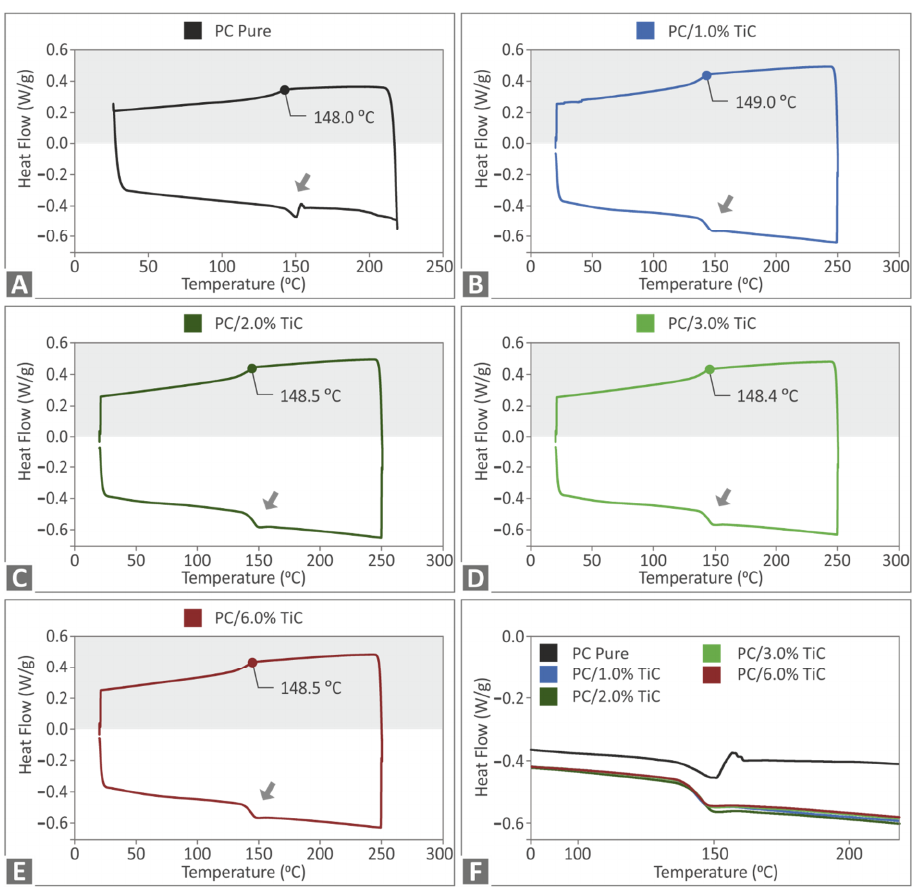
Figure 4. DSC exotherm and endotherm heat flow curve (W/g) to temperature ( ◦ C) for: ( A ) pure PC, ( B ) PC/TiC 1 wt.%, ( C ) PC/TiC 2 wt.%, ( D ) PC/TiC 3 wt.%, ( E ) PC/TiC 6 wt.%, and ( F ) comparison of the exotherm curves for all materials tested.